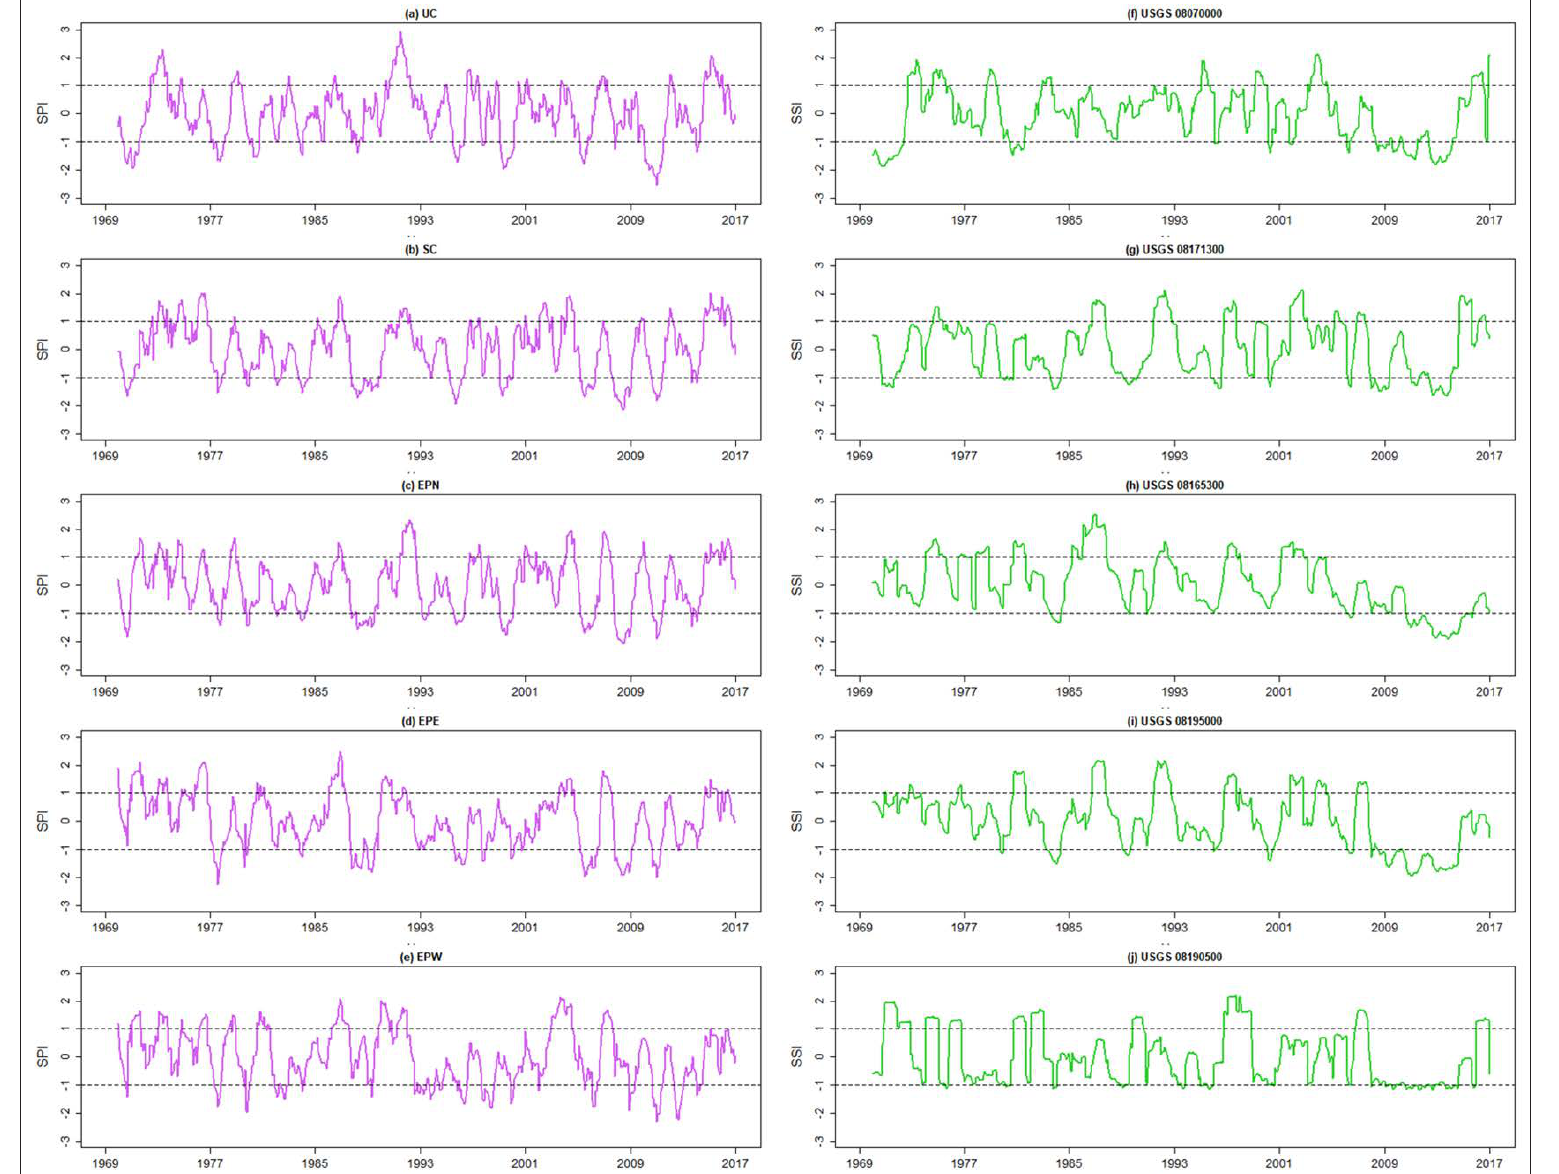
Figure S4. (a) - (e): SPI-12 (from CRU dataset) and (f) - (j): SSI-12 (from USGS gages ) .